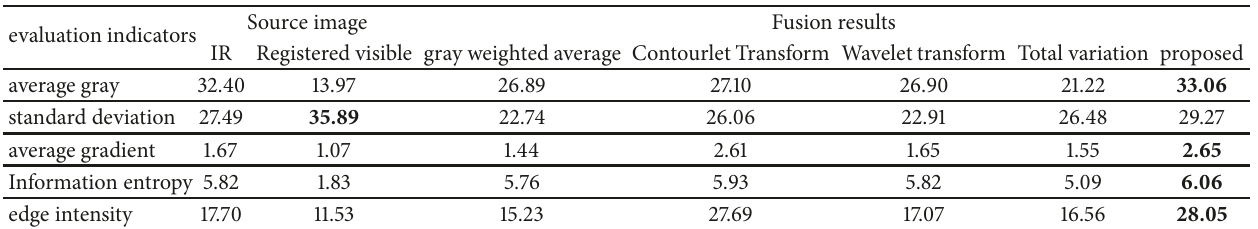
Table 3: Quantitative evaluation of source image and fusion results at